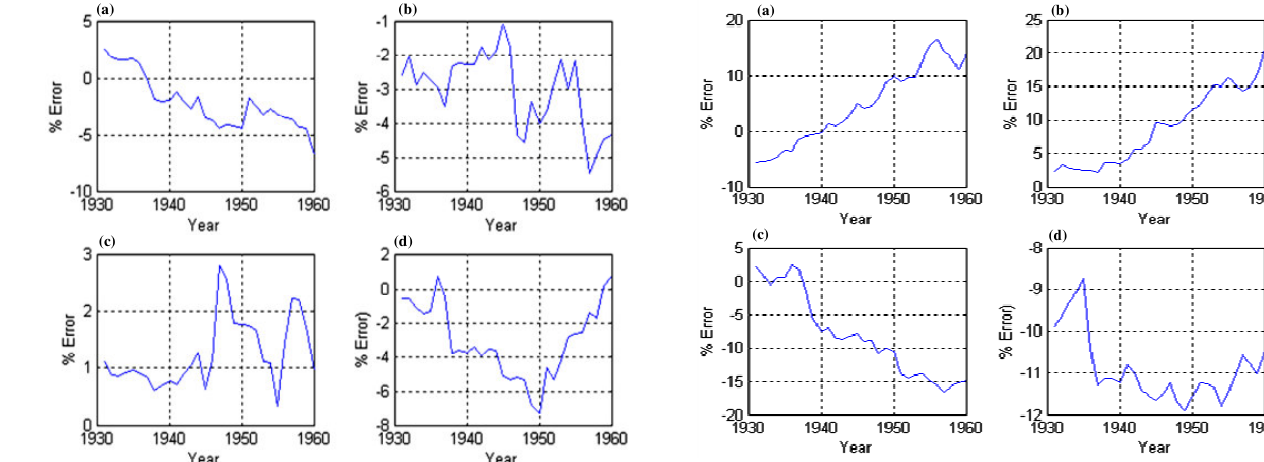
Fig. 11. Error distribution for (a) August (b) December (c) January (d) June.